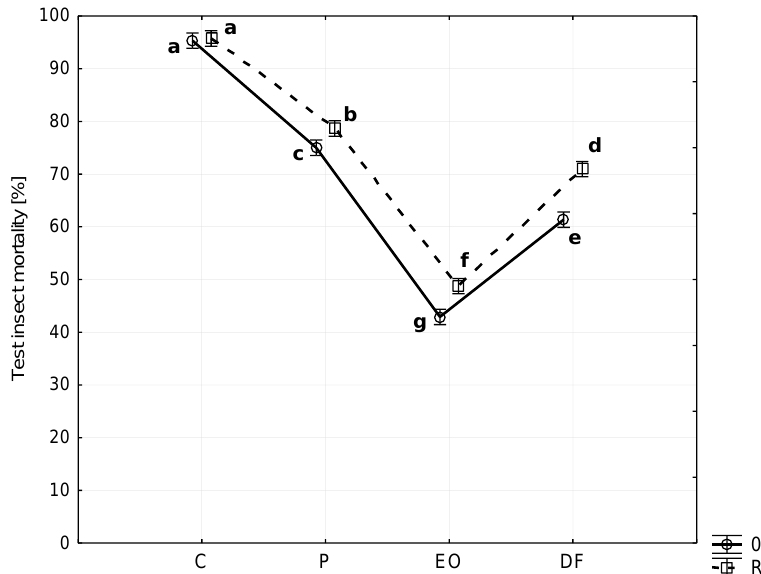
Figure 1. average virulence of S. feltiae for the investigated period. C — unpolluted soil, P — soil contaminated with petrol, EO — soil contaminated with used engine oil, DF — soil contaminated with diesel fuel, 0R — series without bioremediation, R — series with bioremediation. Means marked with the same letters do not significantly differ according to NIR test at α = 0.05; factors contamination x remediation.